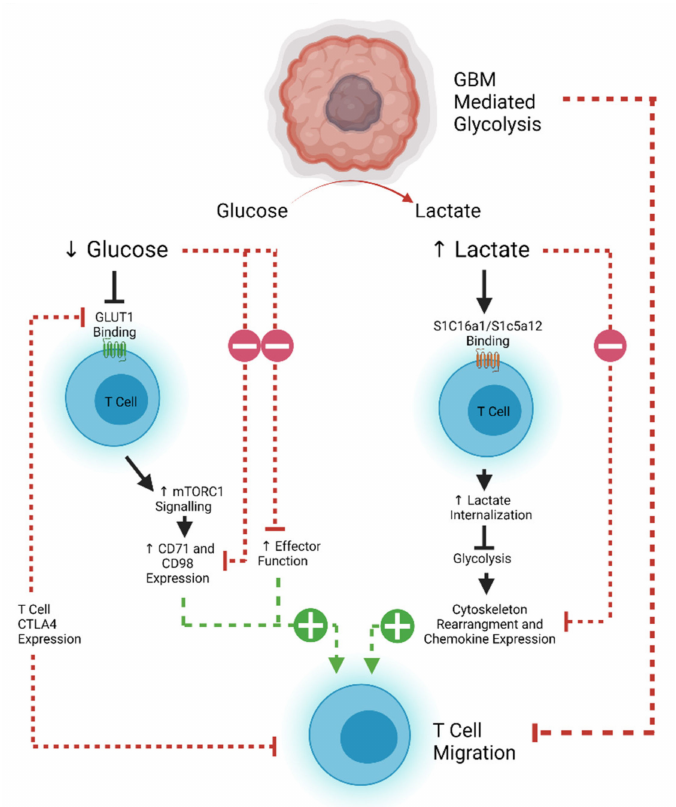
Figure 2. Glioblastoma effects on T cell metabolism and motility. As a rapidly dividing tumor, glioblastoma rapidly takes up glucose and produces lactate (the Warburg effect). Lack of glucose results in decreased GLUT1 binding (also downregulated by CTLA4) and downregulates effector function and motility. Increased lactate is internalized in T cells, where it also inhibits glycolysis and interferes with cytoskeleton rearrangement, resulting in decreased T cell migration. Produced using